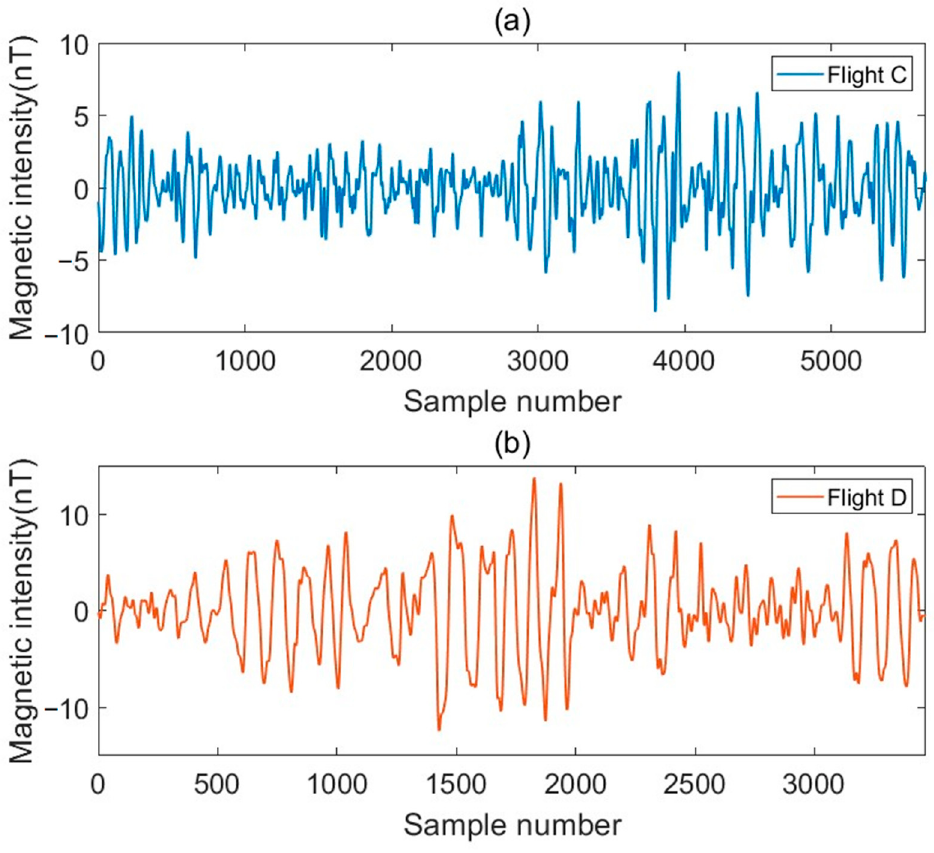
Figure 10. Flight C and Flight D flight paths.